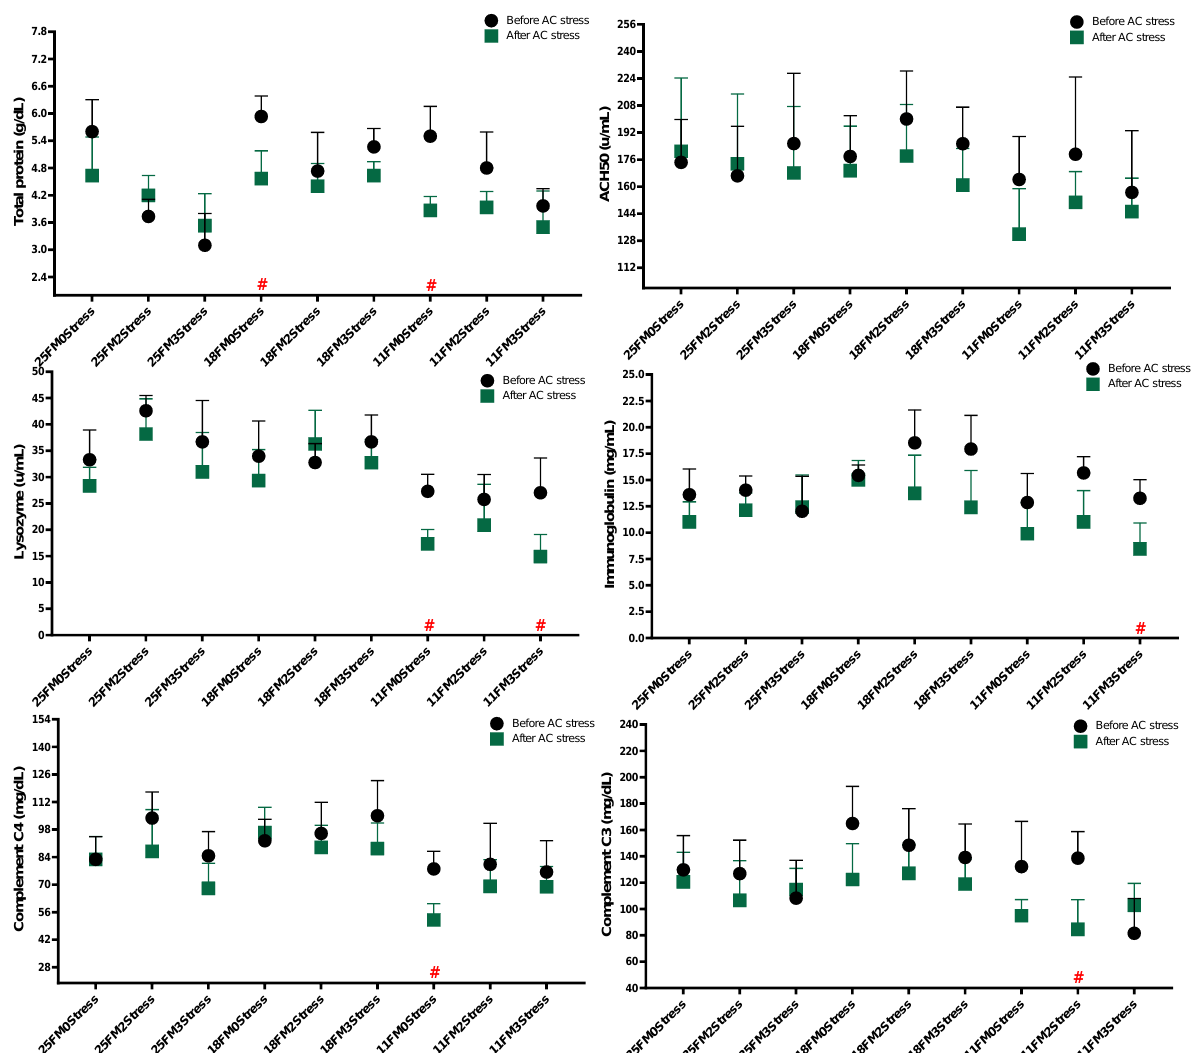
Figure 3. Immune response parameters of oscar fed experimental diets containing different levels of FM and exposed to secluded early mild stress for ten weeks plus data related to after acute confinement stress (AC stress). Values are represented by means and SDM of triplicate samples. Hash (#) with green colour indicates the significant difference in each treatment before and after AC stress according to the independent sample t -test ( p < 0.05).